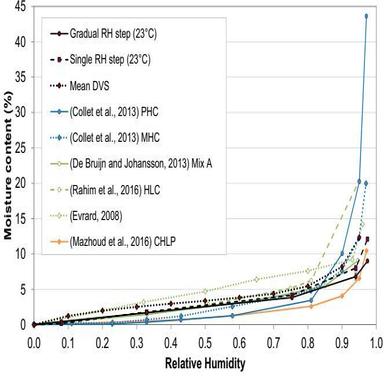
Adsorption isotherm measured with a single RH step equilibrium, gradual RH steps and DVS compared to a few literature references.